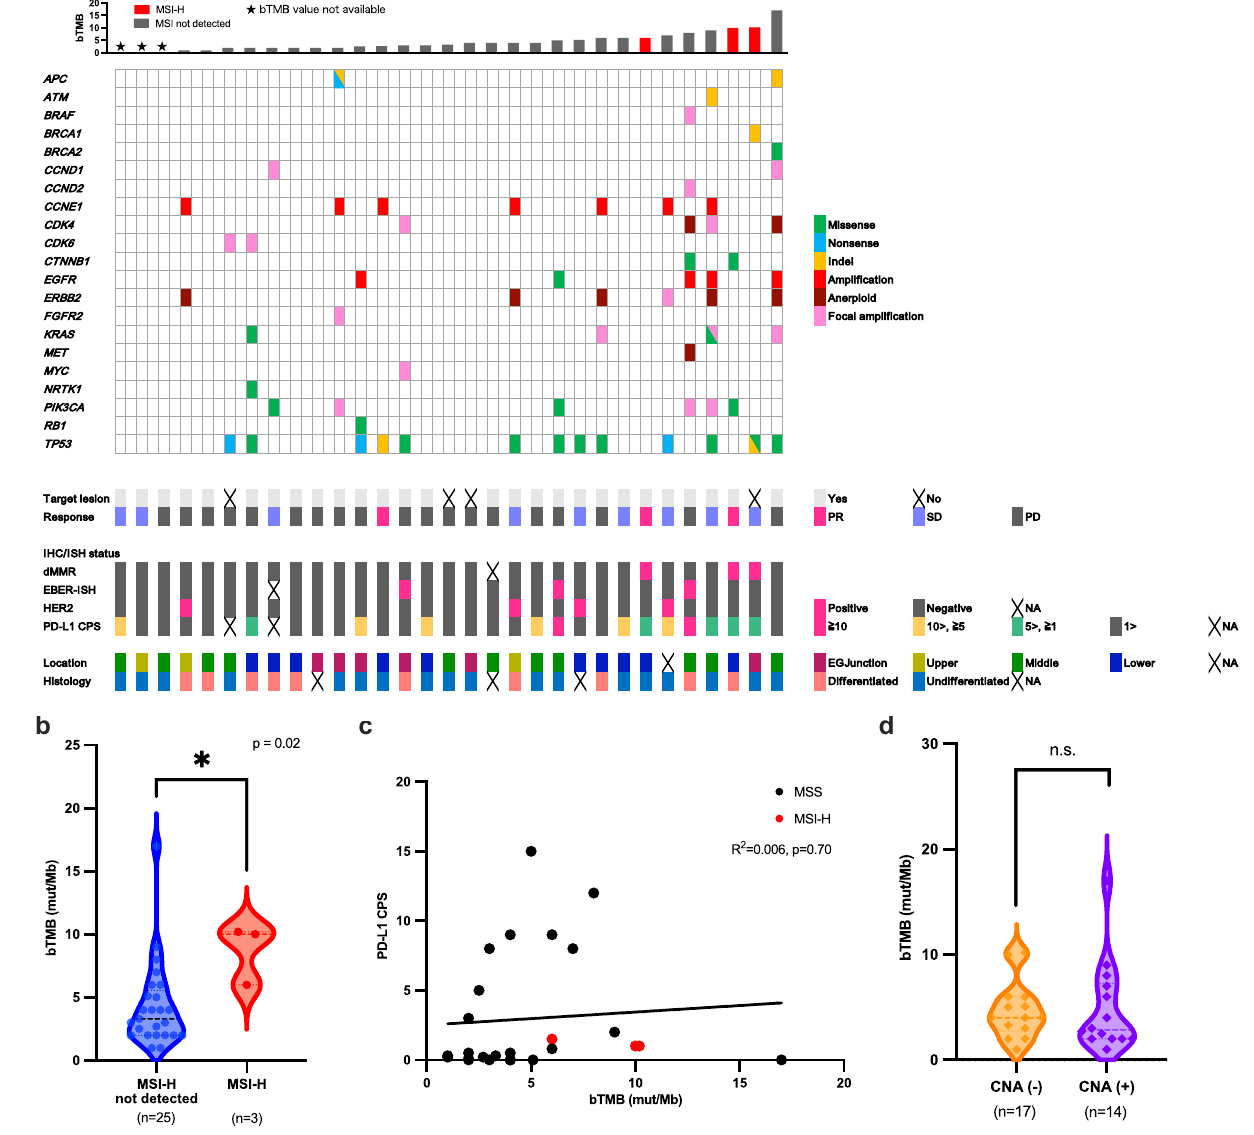
Figure 1. The association between the clinicopathological and genomic features of the study population. ( a ) The landscape of pathological feature observed in tissue samples and genomic alterations detected in baseline plasma samples of 31 gastric cancer patients. ( b ) Comparison of bTMB distribution between tumors with versus without MSI-H. ( c ) Relationship between bTMB and PD-L1 CPS. ( d ) Comparison of bTMB distribution between tumors with or without CNA. bTMB blood tumor mutation burden, CNA copy number alteration, dMMR mismatch repair-deficient, EBER-ISH Epstein–Barr virus (EBV)-encoded RNA in-situ hybridization, HER2 human epidermal growth factor receptor 2, IHC immunohistochemistry, ISH in-situ hybridization, MSI-H microsatellite instability-high, PD-L1 CPS programmed death ligand 1 combined positive score, PD progressive disease, PR partial response, SD stable